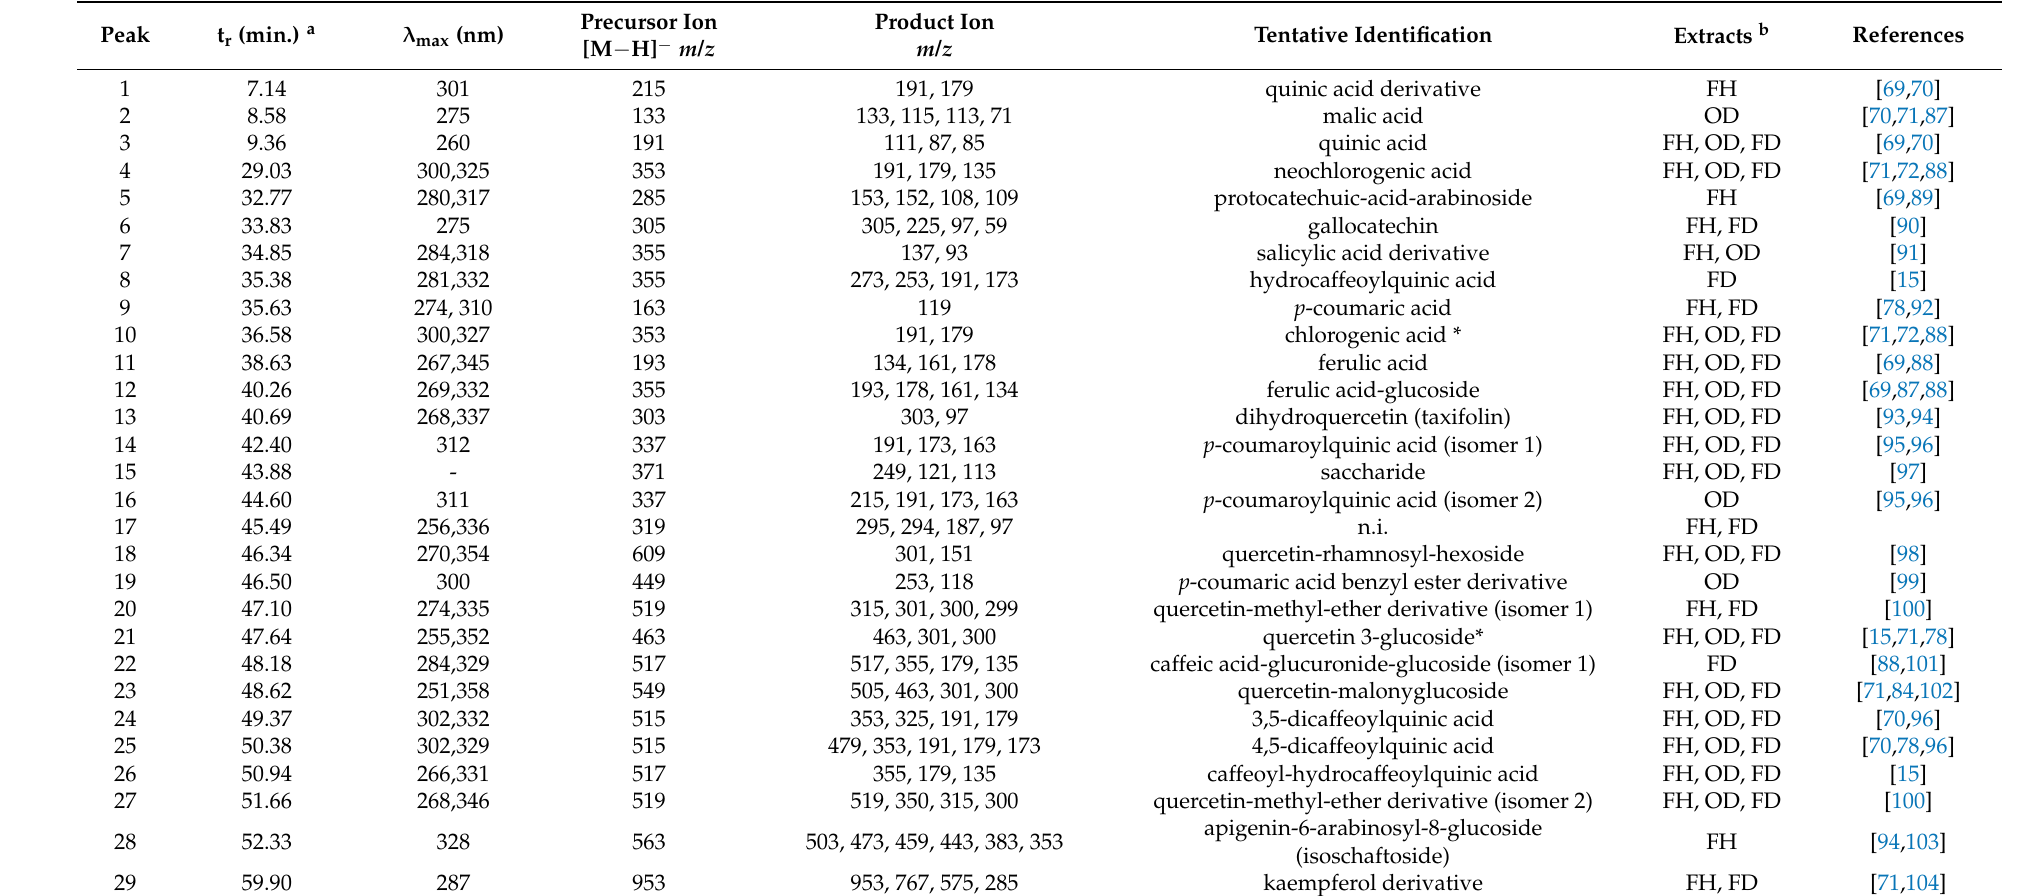
Table 3. Phenolic compounds putatively identified in the fresh, oven-dried, and freeze-dried extracts from S. ramosissima